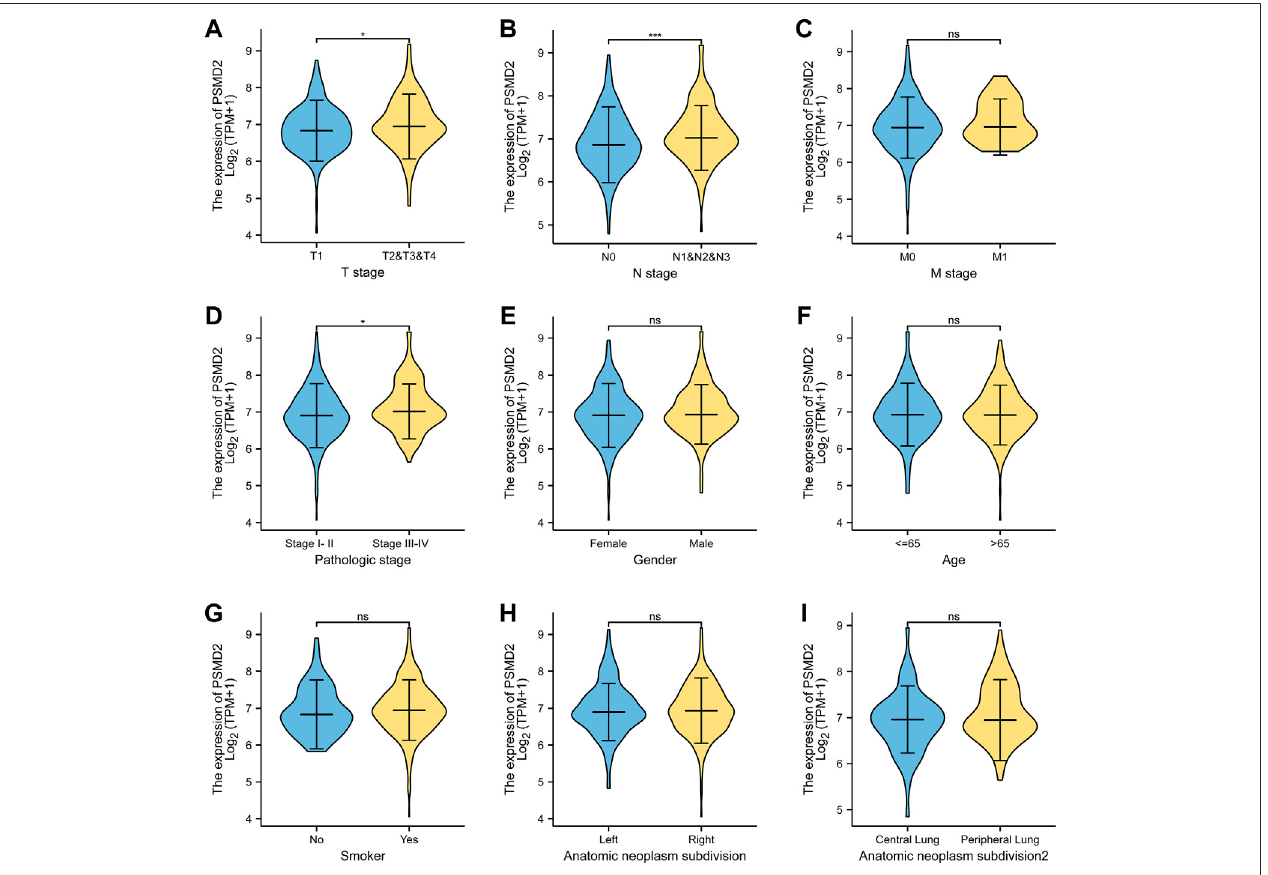
FIGURE 2 | The clinical relevance of PSMD2 expression and clinicopathological factors in lung adenocarcinoma patients. PSMD2 mRNA expression was signi fi cantly increased with high T stage (A) , N stage (B) , and TNM stage (D) . No observed differences in M stage (C) , gender (E) , age (F) , smoke condition (G) , and anatomic subdivision (right vs. left, central vs. peripheral) (H,I) . (ns, no signi fi cance, p p < 0.05, ppp p < 0.001).